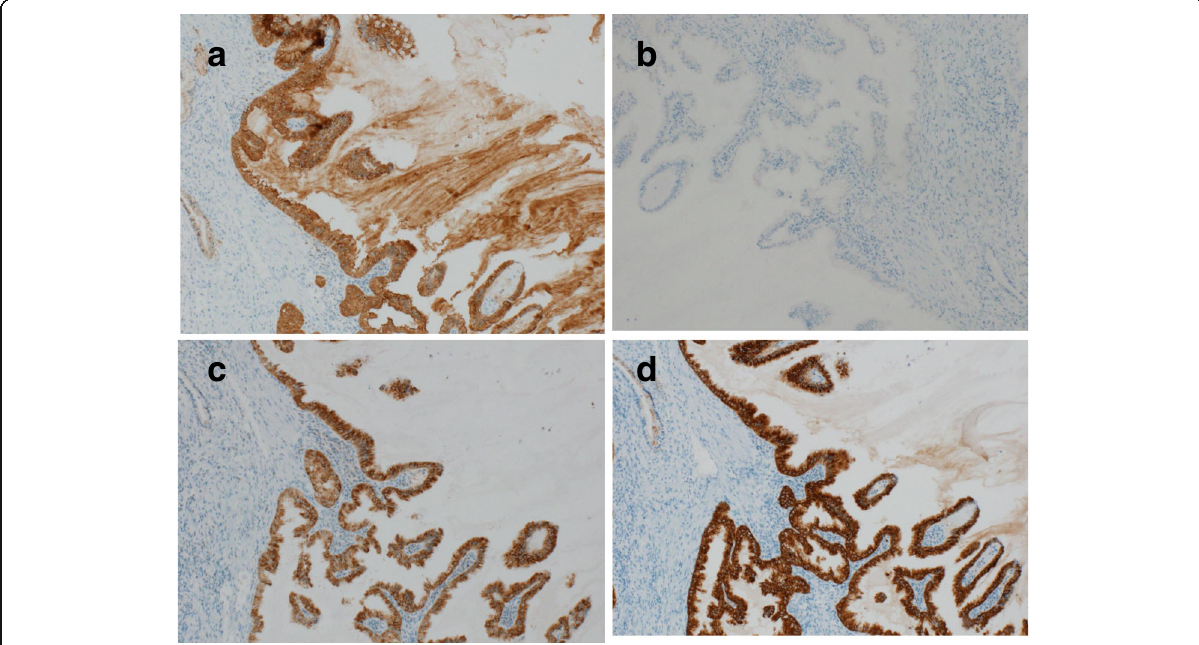
Fig. 4 Immunohistochemical analysis of mucosal characteristics. a MUC1 was positive; b MUC2 was negative; c MUC5AC was positive; and d MUC6 was